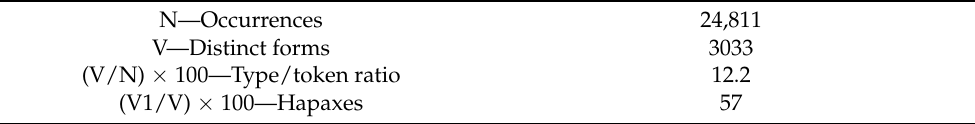
Table 2. Lexicometric measures of the “Food risks during pregnancy”